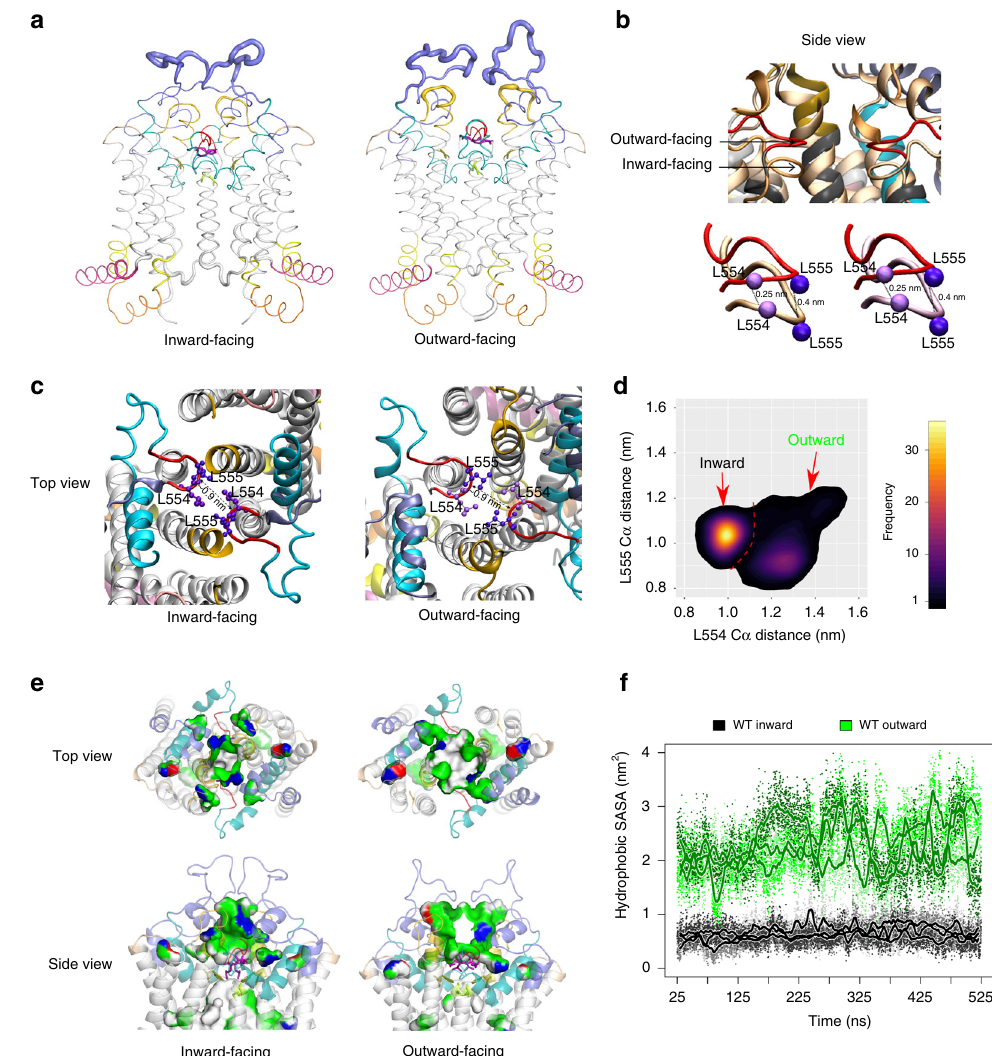
Fig. 6 Conformational dynamics between inward- and outward-facing states. a MD simulations reveal conformational dynamics of the inward- and outward-facing states, quanti fi ed as root mean square fl uctuations (RMSFs), and averaged over the three independent replicates. The results were highlighted in the structure by adapting the thickness of the respective backbone sections. The elbow helix (pink) followed by TMH1 – 6 helices (gray), cytoplasmic distal TMH2, and the TMH3 helical part (yellow), ECL1 (golden), ECL2 (old rose), the short loop after TMH5 (red), the re-entry helix (cyan), and the large extracellular ECL3 (violet). b The zoom-in side views show the overlay of the di-leucine valve between inward- (pale orange) and outward- facing (red) states. The C α atoms of leucine 554 and 555 are in pale and dark purple balls, respectively. c The top view at the di-leucine valve of both states. Dotted lines indicate the distance in nm. d Di-leucine valve distance probability plots, averaged over the three independent simulations of outward and inward-facing ABCG2. e Expansion of the upper cavity. Slice through the upper cavity of the inward-facing and the outward-facing structures showing the polarity of cavity-facing color-coded residues; white (hydrophobic), green (polar), blue (positive charge), and red (negative charge). f Quanti fi cation of the solvent-exposed hydrophobic surface area (SASA) in the upper cavity. Data were obtained from three independent parallel MD simulations of 500 ns for WT in the inward- and outward-open conformations, with 10 ps sampling rate (small dots) and smoothened with a running average of 1 ns (thick